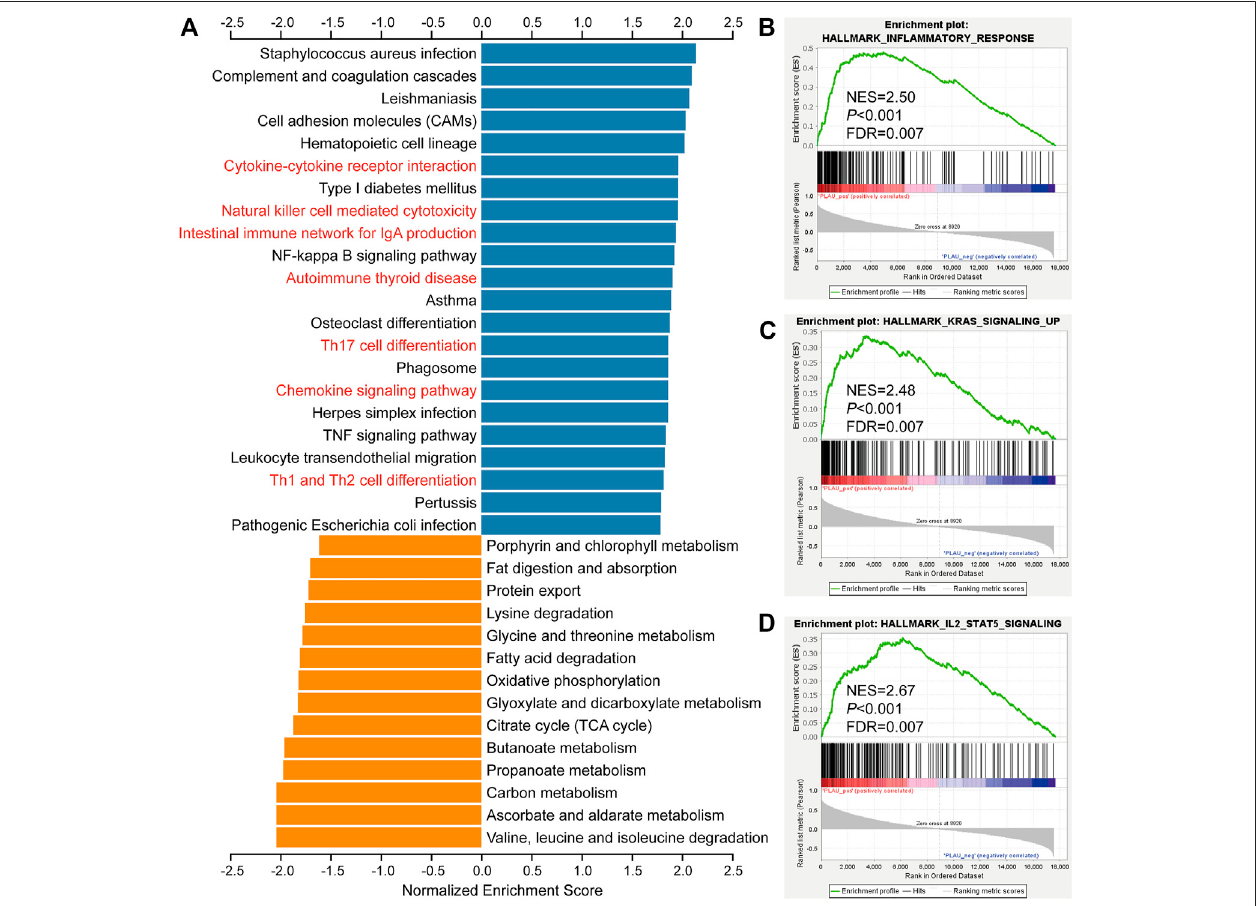
FIGURE5| BiologicalfunctionanalysisofPLAU-relatedgenes. (A) KEGGpathwayanalysisofPLAU-relatedgenes.Up-anddownregulatedgenesareindicatedby blue and orange bars, respectively. (B – D) GSEA of differentially expressed PLAU-related genes, in fl ammatory response pathways, KRAS signaling upregulation pathways, and IL2/STAT5 signaling pathway were signi fi cantly enriched.